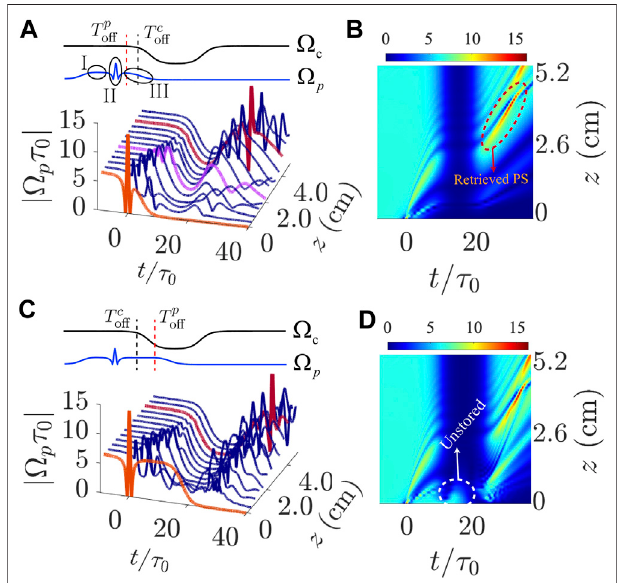
FIGURE3| StorageandretrievalofopticalPeregrinesolitons. (A) Upper part: the black line (blue line) is the time sequence of the control (probe) fi eld, the red dashed vertical line is T p off , and the black dashed vertical line is T c off . Symbols I, II, and III denote the CW background, the Peregrine soliton, and the low-intensity component of the probe fi eld, respectively. Lower part: (cid:4)(cid:4)(cid:4)(cid:4) (cid:4)(cid:4)(cid:4)(cid:4) τ Ω vs. t / τ 0 and z with T p off < T c off ; i.e., the switching-off time of the input p 0 probe fi eld isbefore the time when the control fi eldisswitchedoff. Theorange line represents the input Peregrine soliton at z (cid:2) 0; the purple line represents the probe fi eld at the storage period; the red line represents the retrieved Peregrine soliton propagating to z (cid:2) 4 . 1cm with the maximum intensity (cid:4)(cid:4)(cid:4)(cid:4) (cid:4)(cid:4)(cid:4)(cid:4) τ x 15 . 4 at t x 30 . 3 τ Ω p 0 0 . (B) The contour map of the storage and max retrieval of the Peregrine soliton in the t - z plane with T p off < T c off . The red dashed circle denotes the retrieved Peregrine soliton (i.e., “ Retrieved PS ” ). The upper color bar shows the intensity of the probe fi eld. (C) The same as panel (A) but with T p off > T c off . (D) The contour map of the Peregrine soliton in the t - z plane with T p off > T c off . The unstored component of the probe fi eld is marked by the white circle.